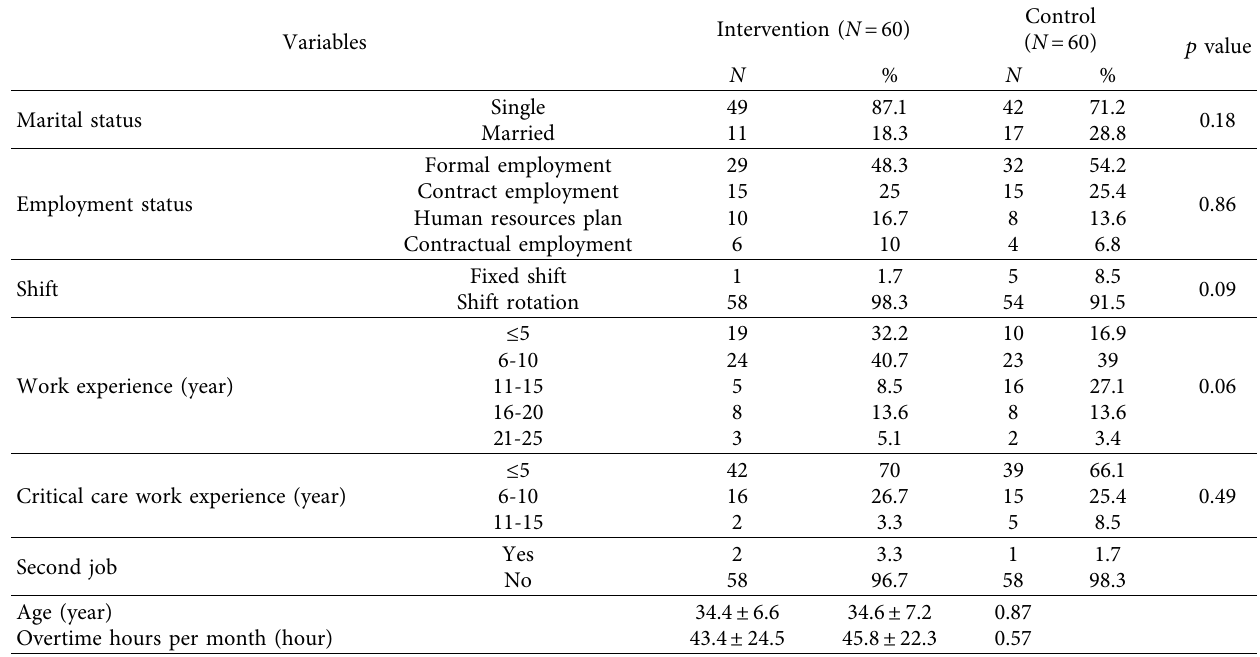
Table 1: Demographic characteristics of